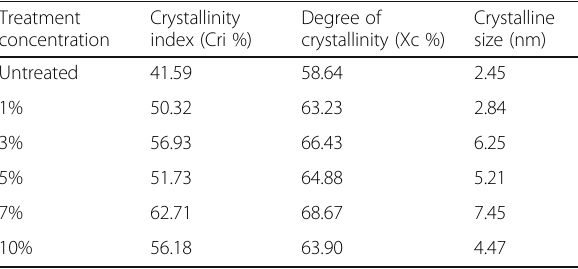
Crystallinity index (Cri %)